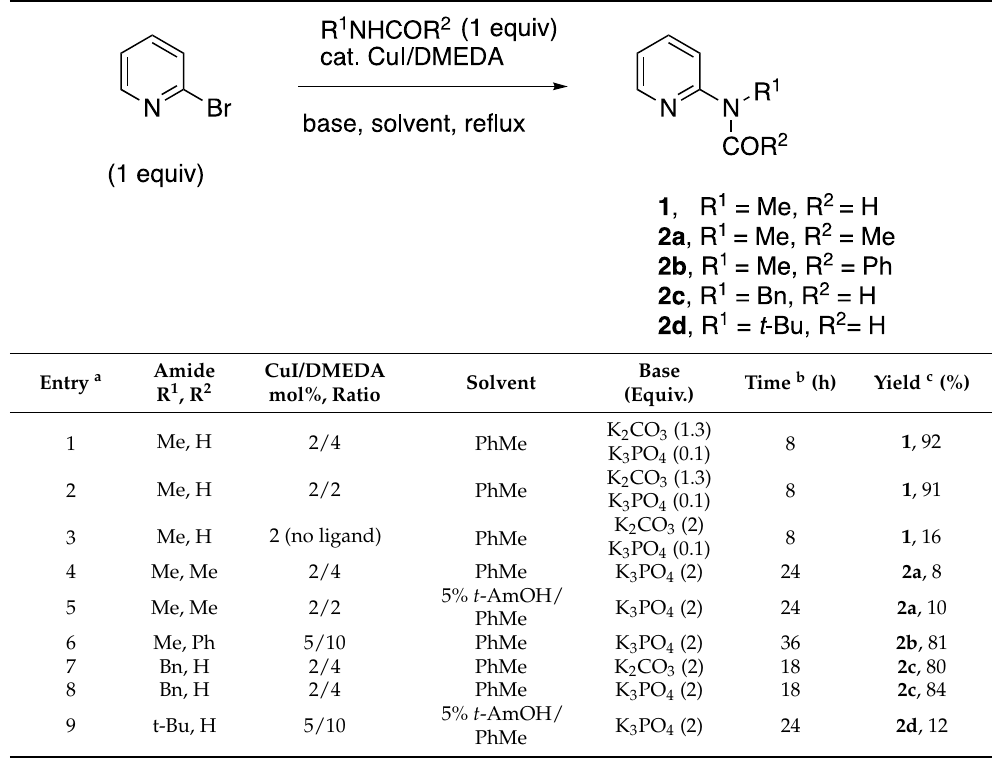
(Table 2, entry 4) was examined. Using a catalyst loading of 5% CuI and 10% DMEDA in toluene for 24 h at reflux, a low yield of the desired cross-coupling was observed (Table 3, entry 9). Table 3. Reactions of 2-bromopyridine and secondary amides using DMEDA as the Table 3. Reactions of 2-bromopyridine and secondary amides using DMEDA as the ligand.